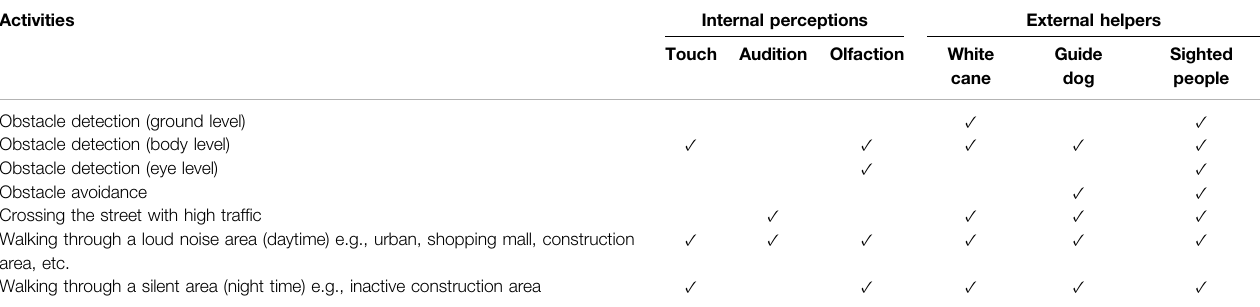
TABLE 1 | The relationship between activities and internal perceptions (Williams et al., 2013; Wifarer, 2016; Watthanasak, 2019).